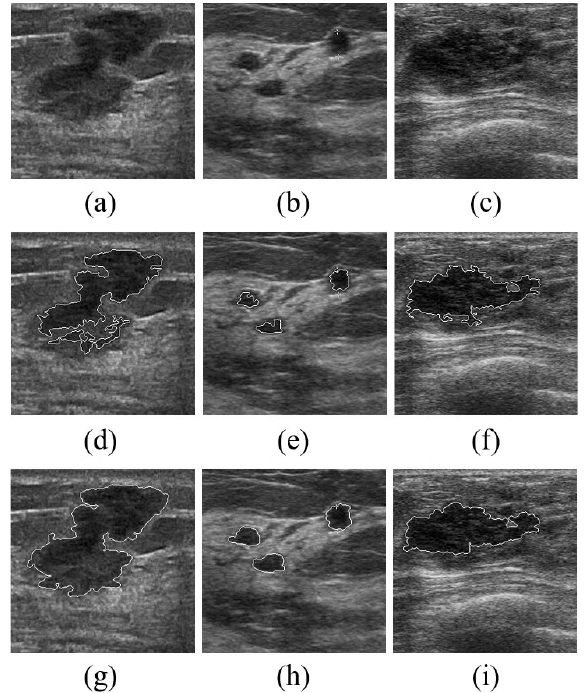
Figure 13. Performance comparison of the contour detection with the proposed CAD. The first row lists original images; second row lists the processing results with the method defined in Equation (1); and third row lists the contour detection with the proposed CAD system. ( a , d , g ) Images fetched with Model B; ( b , e , h ) images fetched with Model B; ( c , f , i ) images fetched with Model